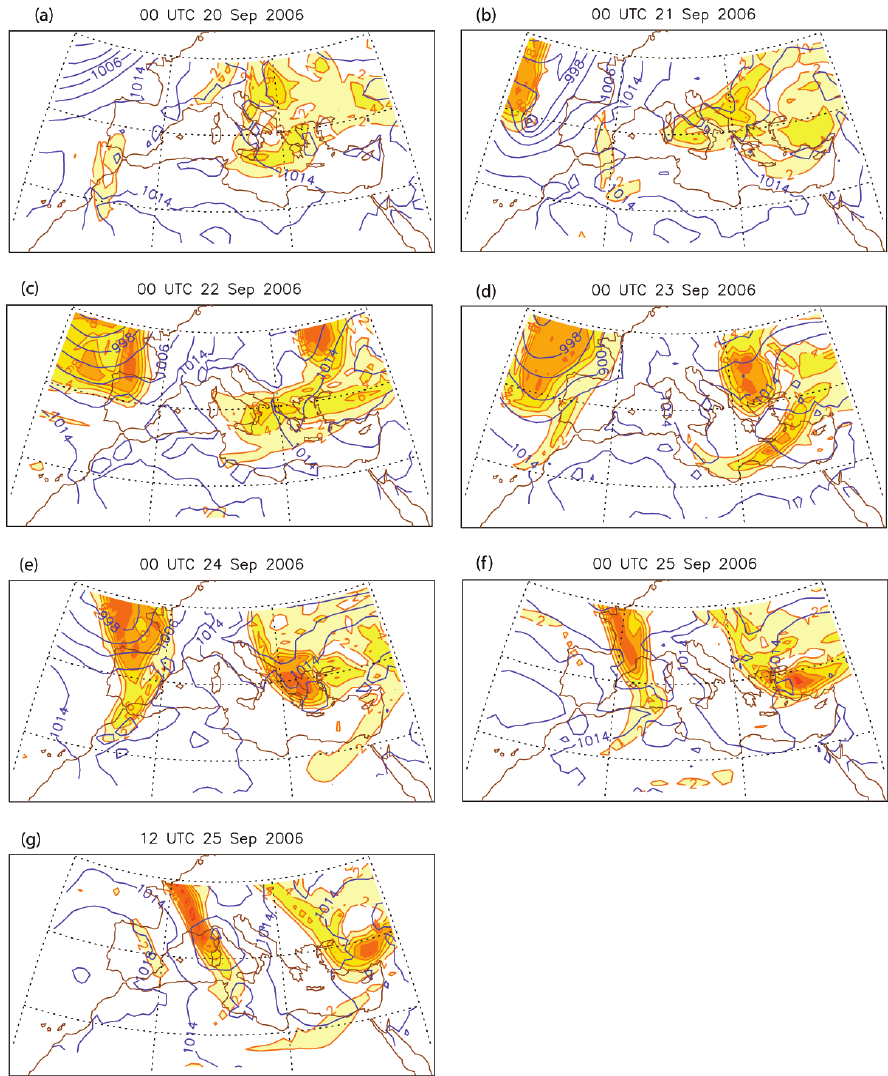
Fig. 6. ECMWF operational mean sea level pressure (in hPa, every 4hPa) and potential vorticity (in PV Units; 1PVU=10 − 6 Km 2 kg − 1 s − 1 ) at 250hPa for the period from 20 September 2006 until 25 September 2006,